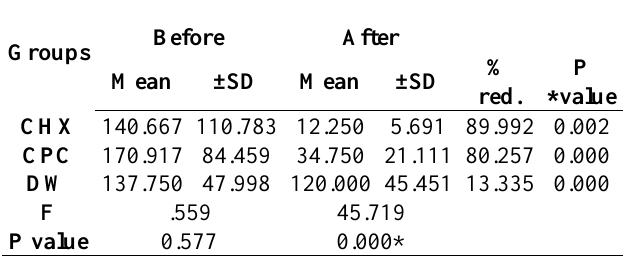
Table 4: Bacterial count mean and reduction among groups before and after rinsing in dentist chest.